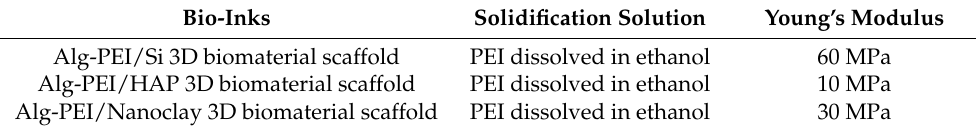
Table 1. The comparison of Young ’ s modulus of the three different printed scaffolds. Bio-Inks Solidification Solution Young’s Modulus Alg-PEI/Si 3D biomaterial scaffold PEI dissolved in ethanol